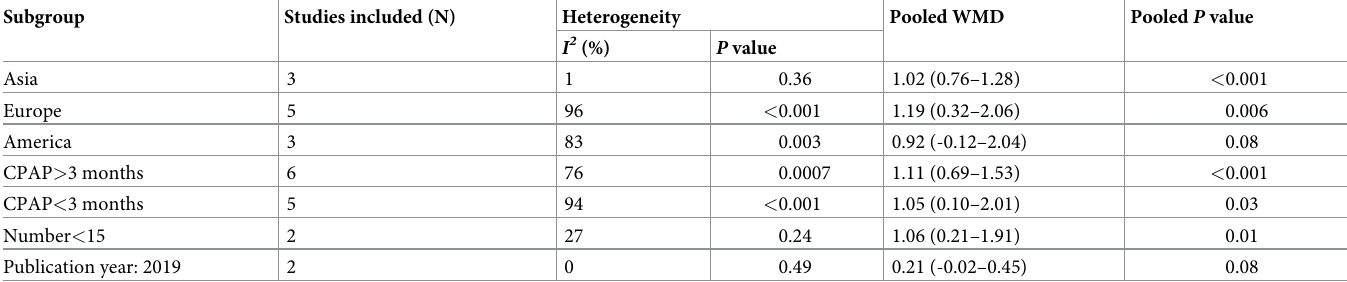
Table 2. Results of subgroup analysis among included